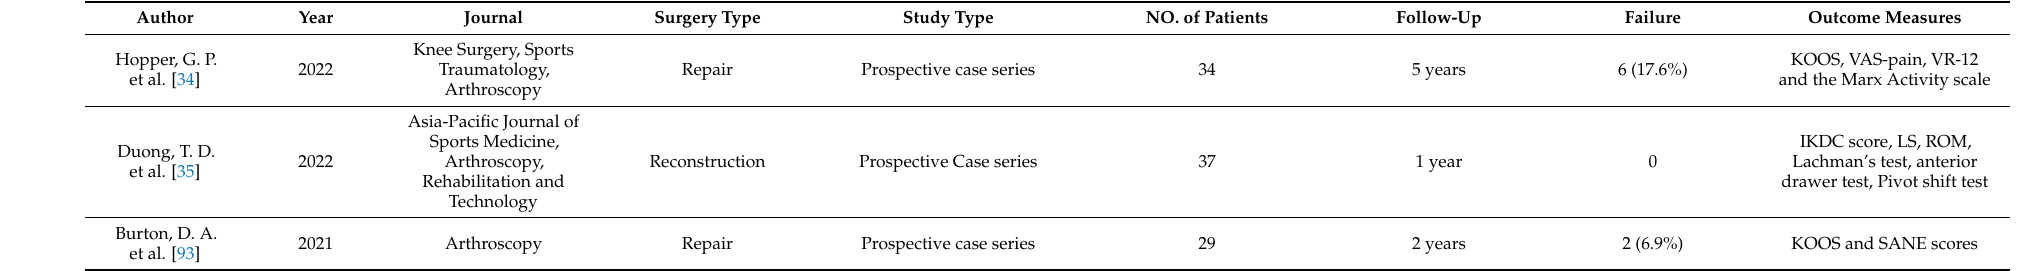
Table 2. Clinical Studies of ACL Primary Repair or reconstruction with